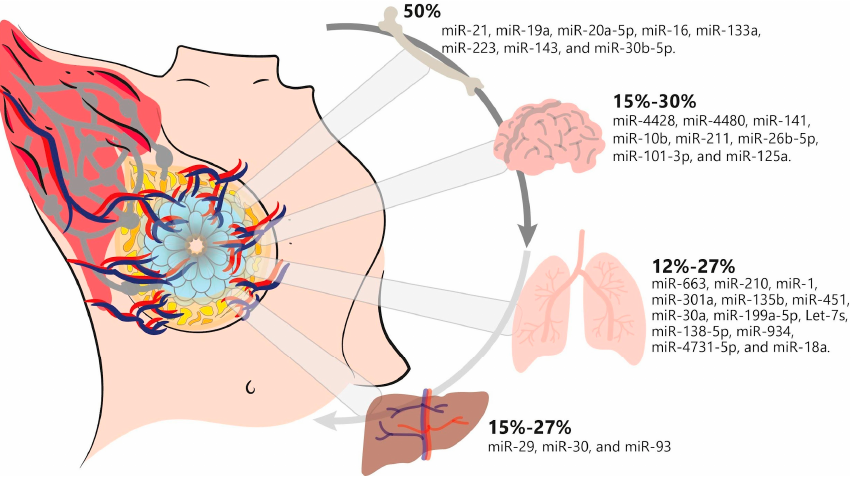
Figure 2. miRNAs associated with metastasis to different organs in breast cancer. The percentage of the incidence of miRNAs implicated in BC metastatic process to the principal organs affected is summarised, with bone being the most-affected organ and the liver and lungs occupying the lowest incidence rates.